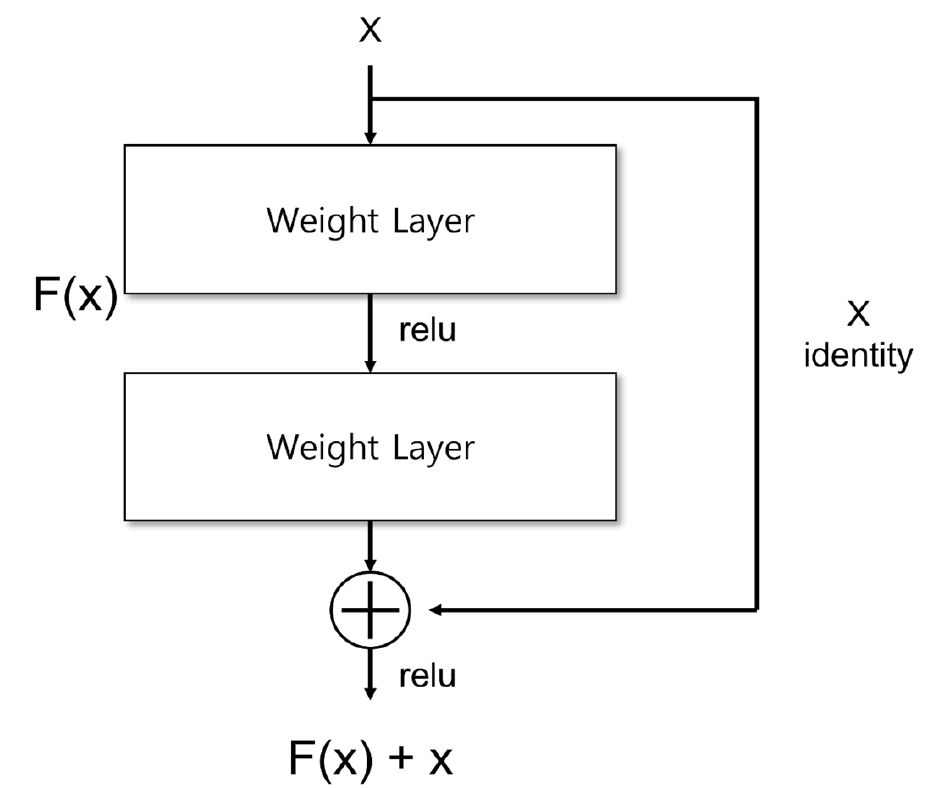
Figure 1. ResNet34 shortcut structure.